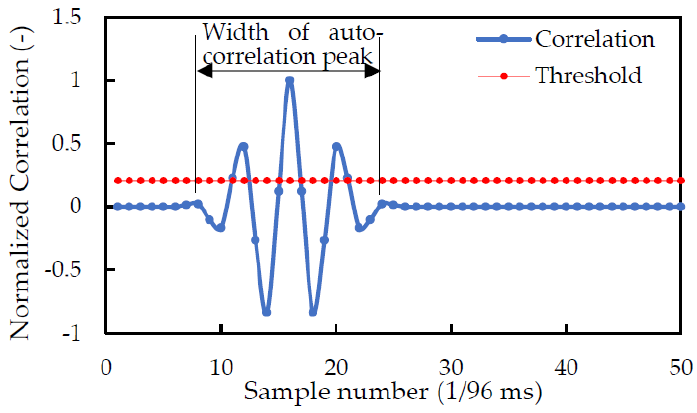
Figure 2. Auto-correlation value.